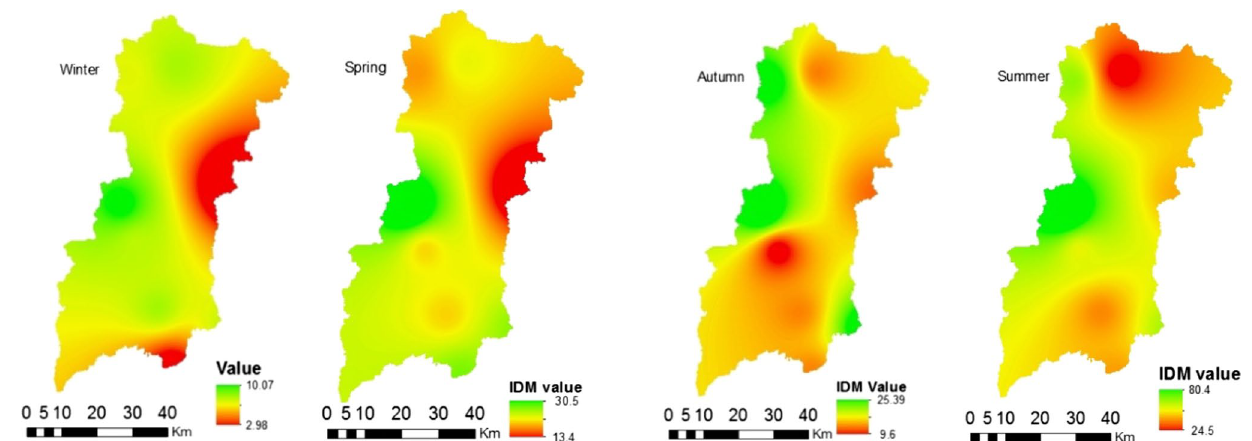
Fig. 2 Annual coefficient of determination between the indi- ces of DeMartonne aridity index and Pinna combinative index (left), DeMartonne aridity index and FAO aridity index (center), Pinna combinative index, and FAO aridity index (right)